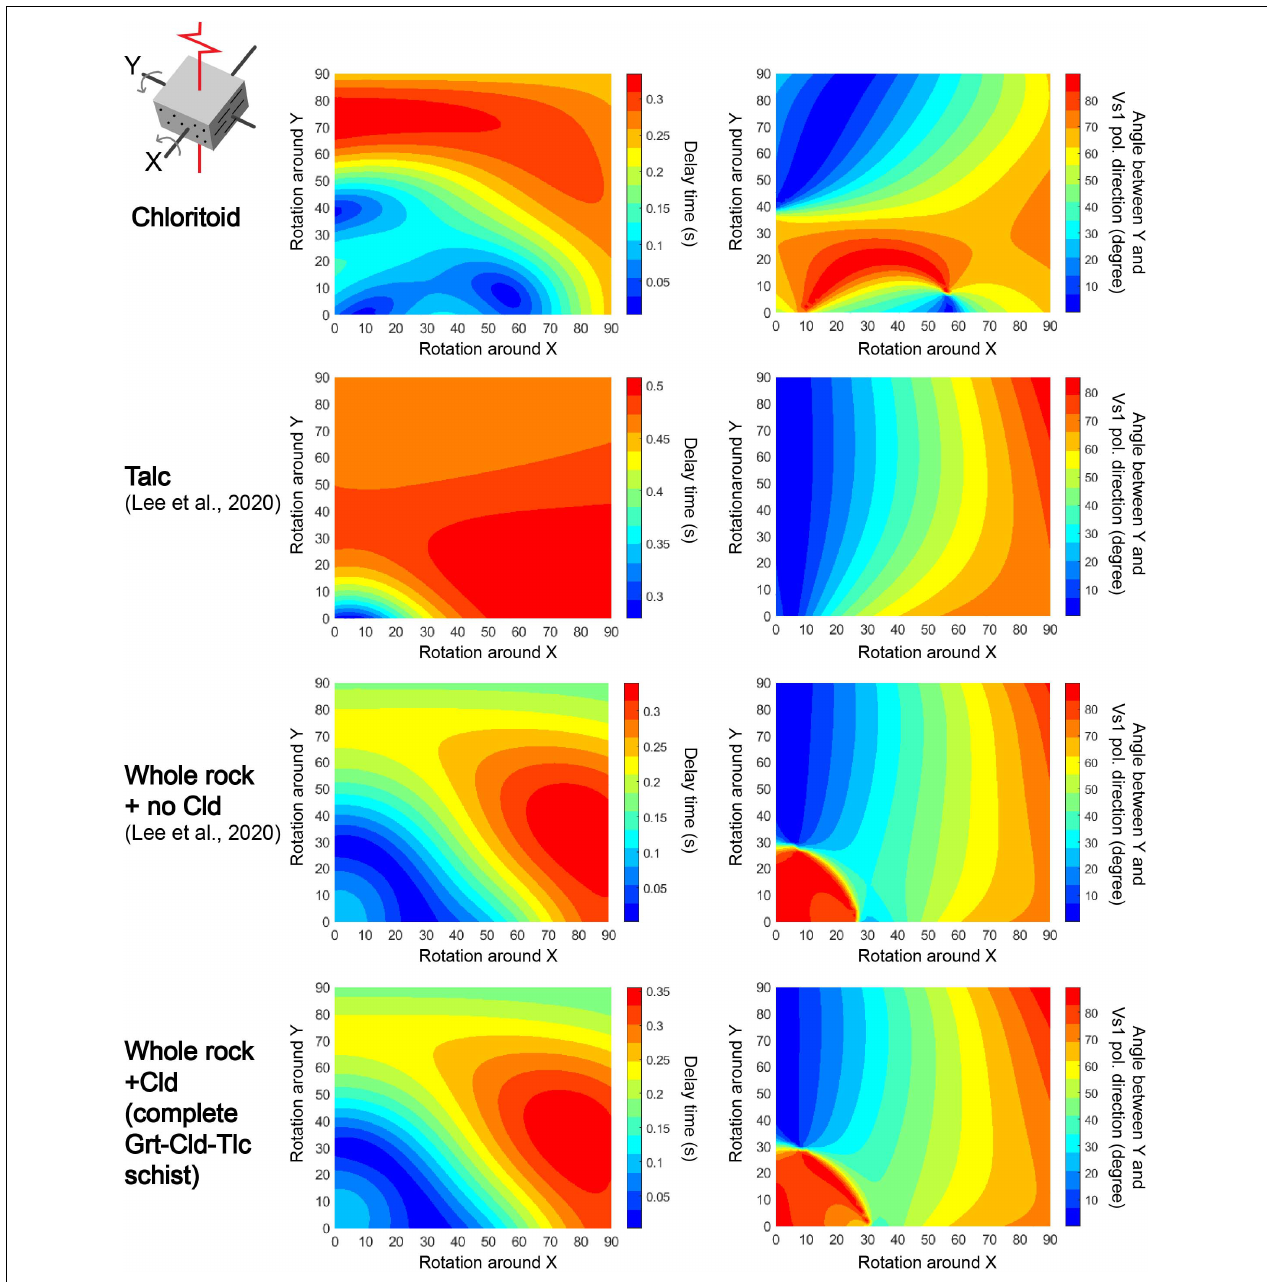
FIGURE 8 | Illustration of the 3–D effect of chloritoid, talc, and the Grt-Cld-Tlc schist on a vertically incident S-wave. LPO data of garnet and talc (Lee et al., 2020) and chloritoid (this study) of sample #15R were used for the calculation. An anisotropic layer with a thickness of 10 km was assumed. The rotation around X and Y from 0 ◦ to 90 ◦ was illustrated to display the effect of the dipping foliation (X-Y plane) where X is parallel to the shear direction and Y is parallel to the strike of the hypothetical trench. The left column shows contour plots displaying the effect of sample orientation on the delay time (dt), with blue (short delay times) to red (long delay times) colors. The right column shows contour plots displaying the variation of the angle between the fast S-wave polarization direction (V S1 pol. direction) and the hypothetical strike of the trench (Y) as the sample is rotated around X and Y. Colors range from blue (trench–parallel fast directions) to red (trench–normal fast directions). In the uppermost left, the schematic sample geometry is illustrated to show how the sample (X–Y plane = foliation, dots, and lines = lineation) is rotated with respect to the incoming S-waves (red line).